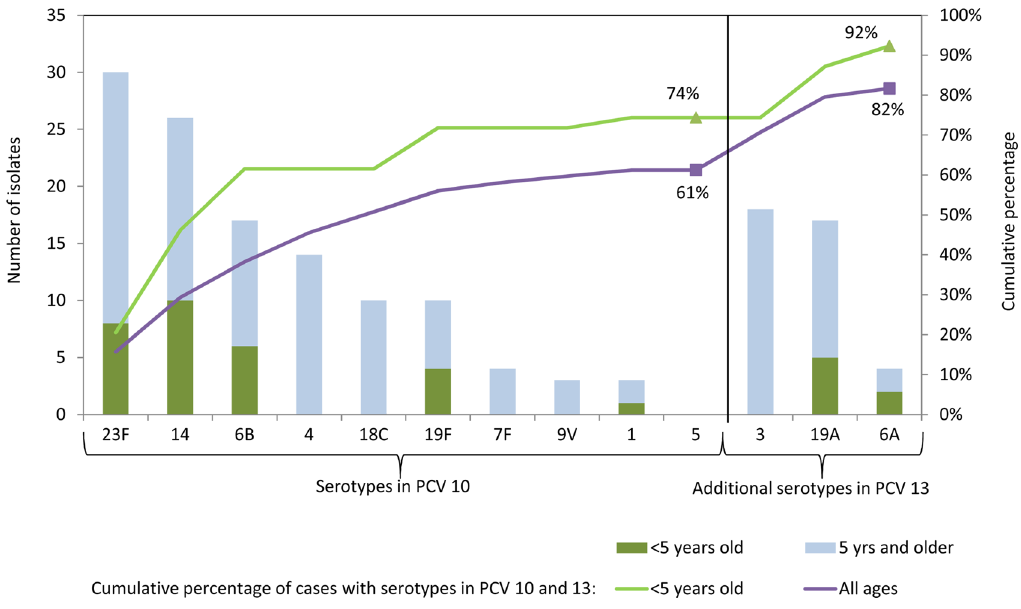
Figure 3. Serotype distribution of isolates from pneumococcal bacteremia cases: limited to serotypes contained in PCV10 and PCV13*. * Non-vaccine serotypes included: 11A (5 cases); 35B (3 cases); 7C, 10A, 23A, 34, (2 cases each), 8, 13, 15A, 15B, 16F, 18F, 20, 22F, 23B, 24F, 31, 35C, 35F and 38 (1 case each). The serotypes for five cases were not identified by the multiplex PCR protocol and these isolates were not available for serotyping by other methods.